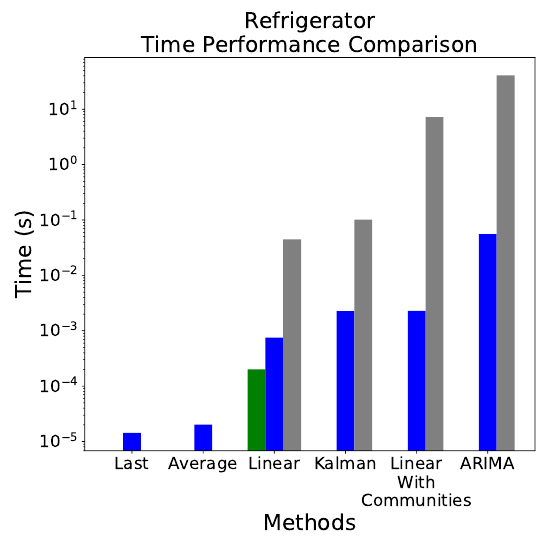
Figure 7. Time, in seconds, each method took to be trained (grey bars) and forecasting (blue bars) for the refrigerator data set. The (only) green bar refers to the Arduino Uno forecasting tests performance. The values refer to a total of 100 consecutive executions of the same